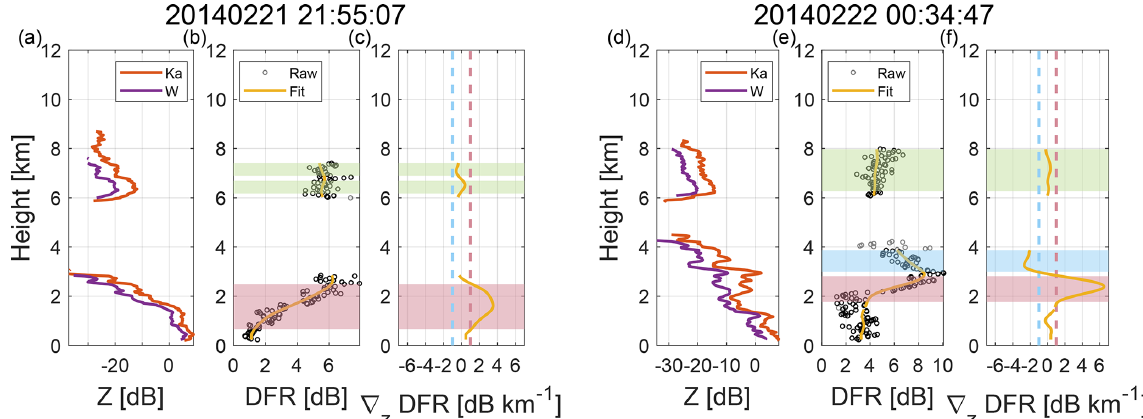
Figure 3. Examples of application of the DFR Rayleigh plateau method on two profiles measured at the Hyytiälä Forestry Field site on 21 February 2014 at 21:55:07UTC (a, b, c) and at 00:34:47UTC (d, e, f) . Panels (a, b) feature the reflectivity measured at K a and W band. Panels (b, d) show the corresponding raw (circles) and smoothed (yellow line) DFR, while panels (c, f) display the DFR gradient (yellow line). Red and blue shading represent heights where the gradient exceeds ± 1dBkm − 1 while green shading shows the part of the profile that has been identified as a Rayleigh